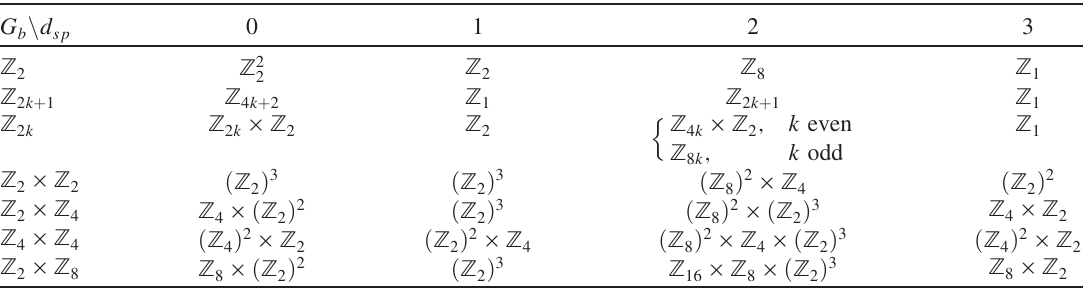
Z 2 Z 1 3 ð Z 2 Þ 2 × Z Z 2 Þ 4 ð 3 Z 2 Þ